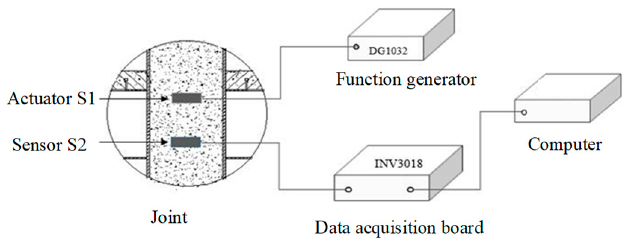
Figure 7. Schematic of the test monitoring system.